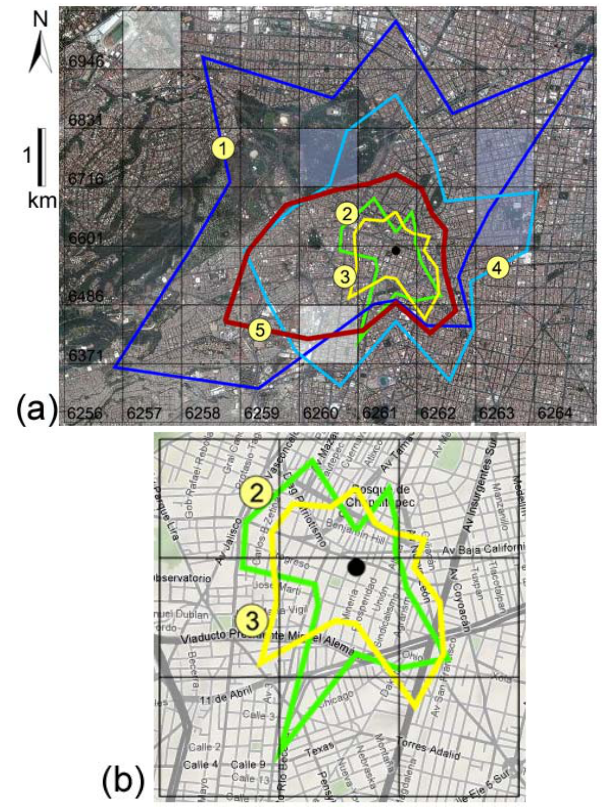
Fig. 1. Footprints encompassing 80% of the measured flux during the entire study as a function of the wind direction for different in- tervals of the day: (1) from midnight to 6a.m., (2) from 6a.m. to 12p.m., (3) from 12p.m. to 6p.m., and (4) from 6p.m. to midnight. The footprint number (5) corresponds to the average footprint for the entire set of measured periods. (a) The footprints are plotted over an aerial photograph of the study area including the 1 × 1km grid cells of the emissions inventory. The reference numbers on the left and bottom correspond to the cells numeration in the emis- sions inventory. The lightly shaded gray cells are cells with suspi- cious emissions during daytime in the emissions inventory, while the darker blue shaded cells represent suspicious emissions during nighttime. (b) Zoom of the daytime footprints superimposed on a map of the study area. Both, the aerial photograph and the map were taken from Google-Maps©